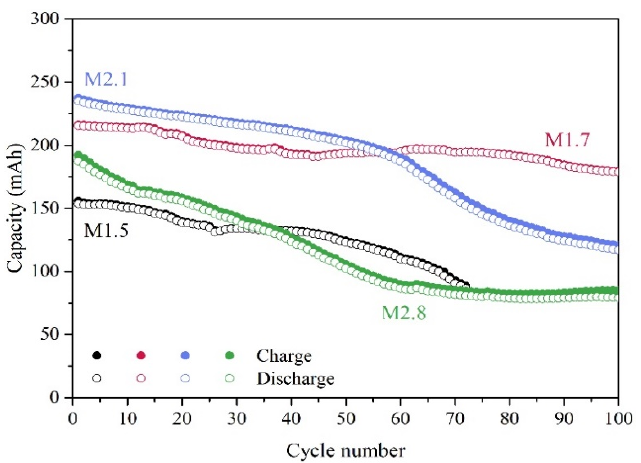
Figure 6. Charge/discharge capacity of the four kinds of PPOQ-DAPCl AEM at 80 mA·cm −2 over 100 cycles in TMA-TEMPO/MV (1.12 M/1.49 M) based ORFB single cell. The cell was primed at 20 mA·cm −2 for one cycle. Cutoff voltage: 0.9/1.5 V. The charge/discharge of the cell with M1.5 from 72nd cycle became invalid due to leakage; thus, data is not shown.